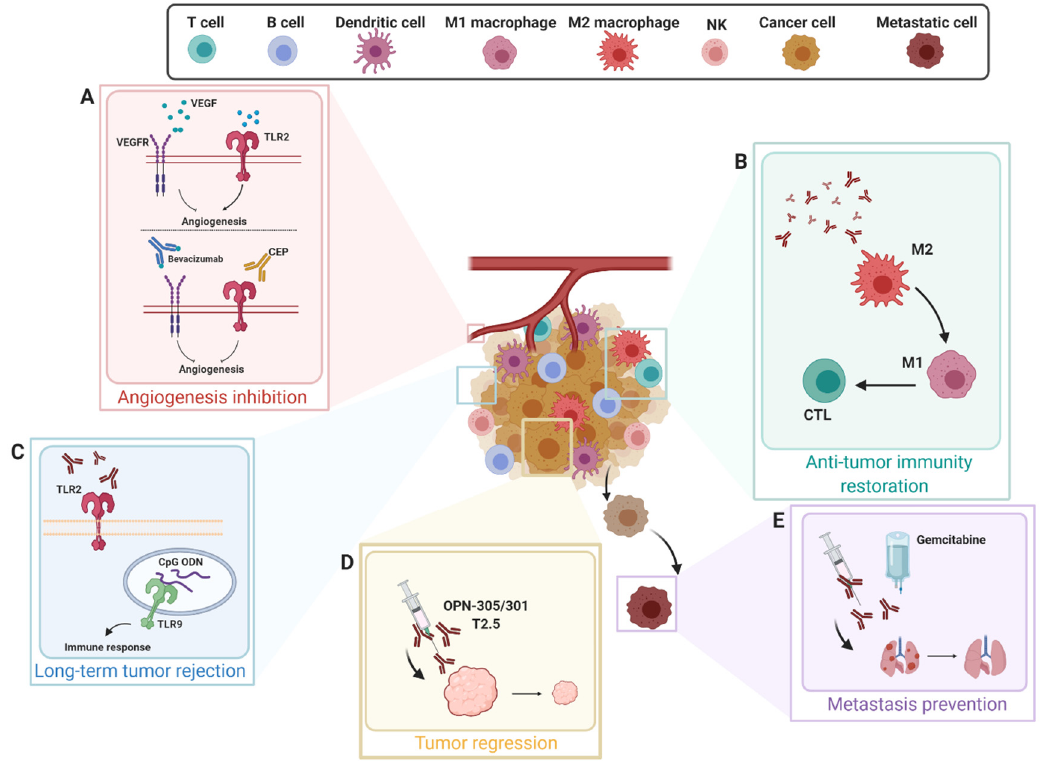
Figure 4. TLR-2 Targeted Anti-Tumor Therapies. TLR2 inhibition has an impact in hampering many aspects of tumor progression. ( A ) The engagement of TLR2 ligands such as 2-( ω -carboxyethyl)pyrrole